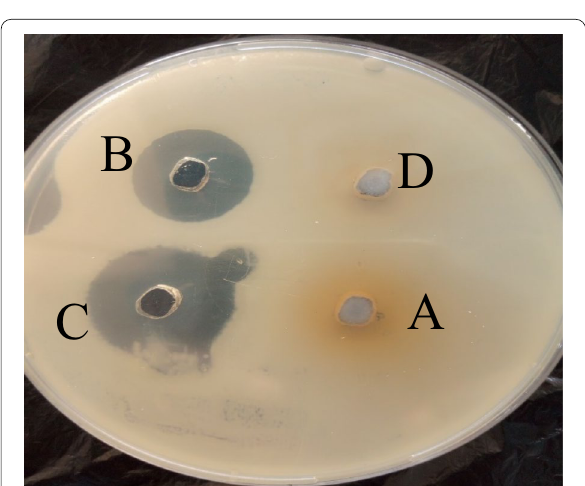
Mean Standard Error Superscript a, b, c ±